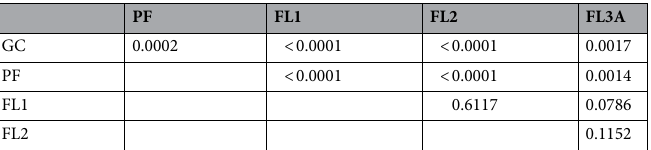
Table 2. p -value in comparisons of abnormal type 53BP1 expression among follicular-shape lymphoid lesions. GC germinal center, PF primary follicle, FL 1, 2, 3A follicular lymphoma grade 1, 2, 3A.